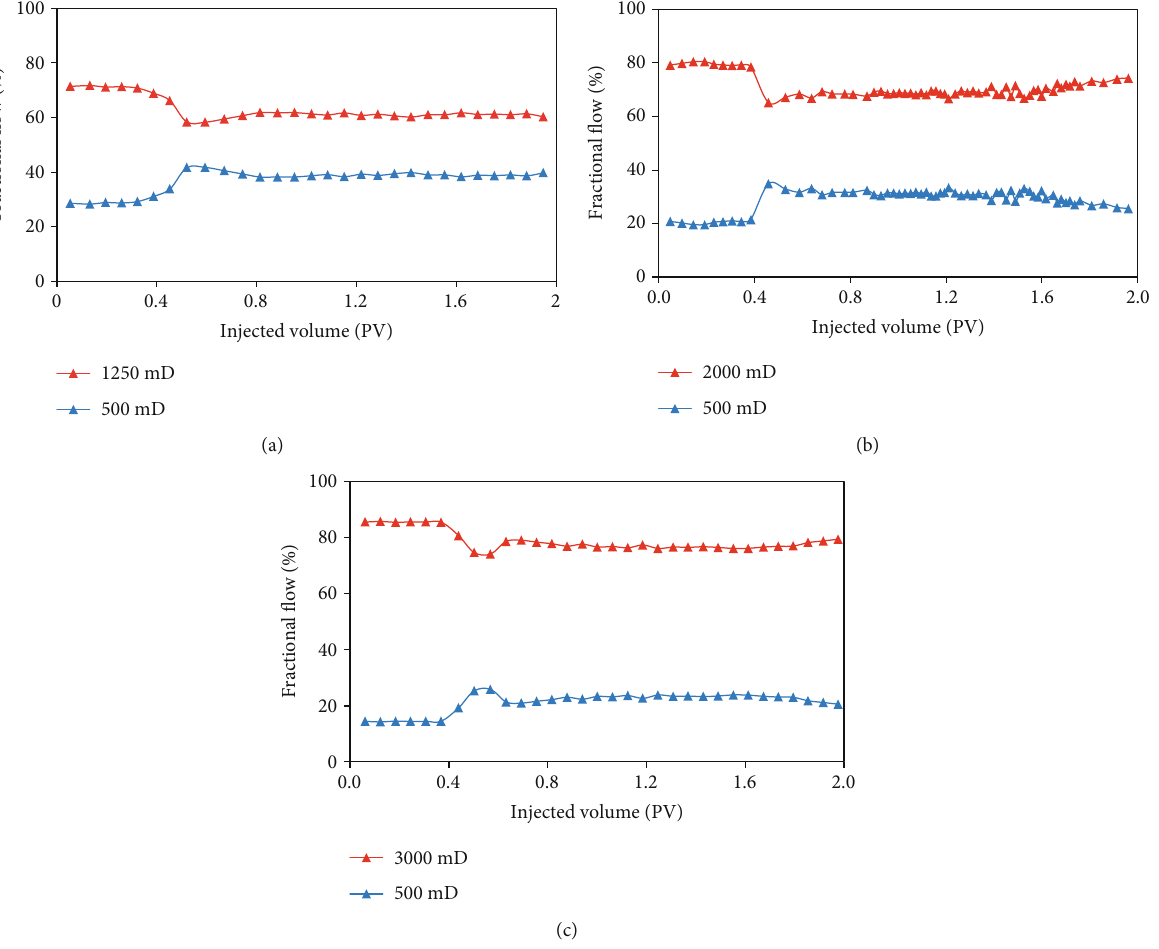
Figure 9: Fractional fl ow of di ff erent permeability ratio cores during brine injection and emulsions injection. (a) Permeability ratio is 2.5; (b) permeability ratio is 4; (c) permeability ratio is